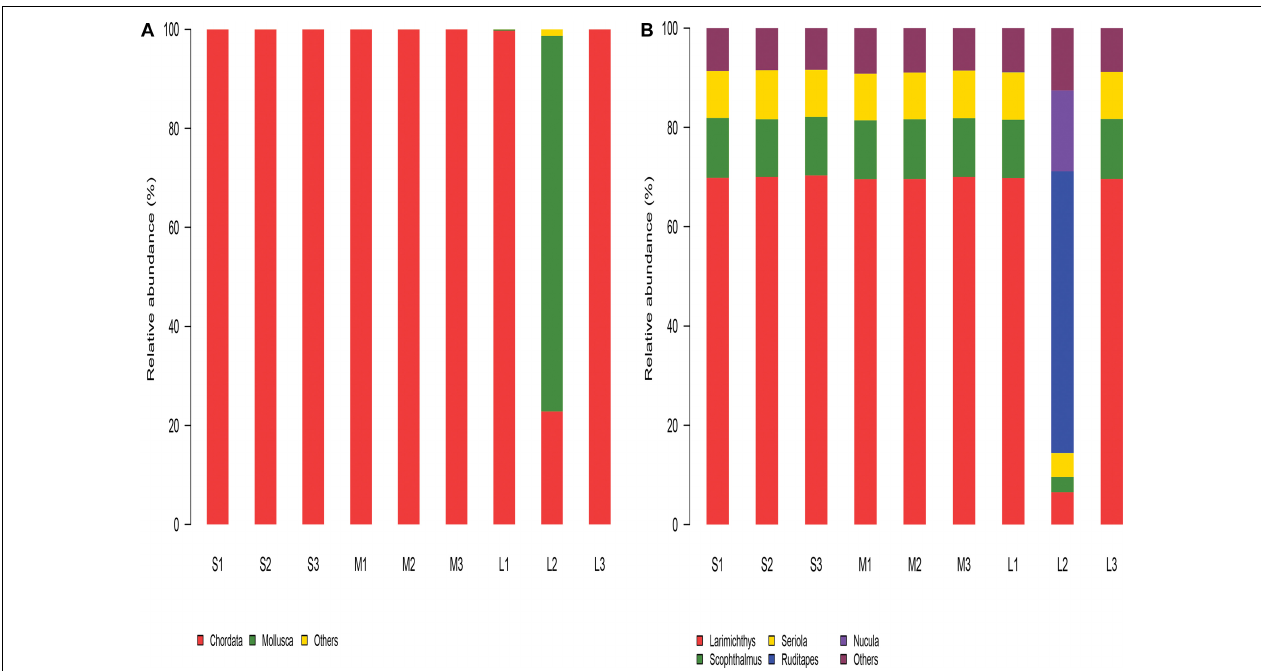
FIGURE 2 | The relative abundance of the eukaryotic composition in the stomach content samples. (A) Relative abundance of the eukaryotic composition at the phylum level. (B) Relative abundance of the eukaryotic composition at the genus level.